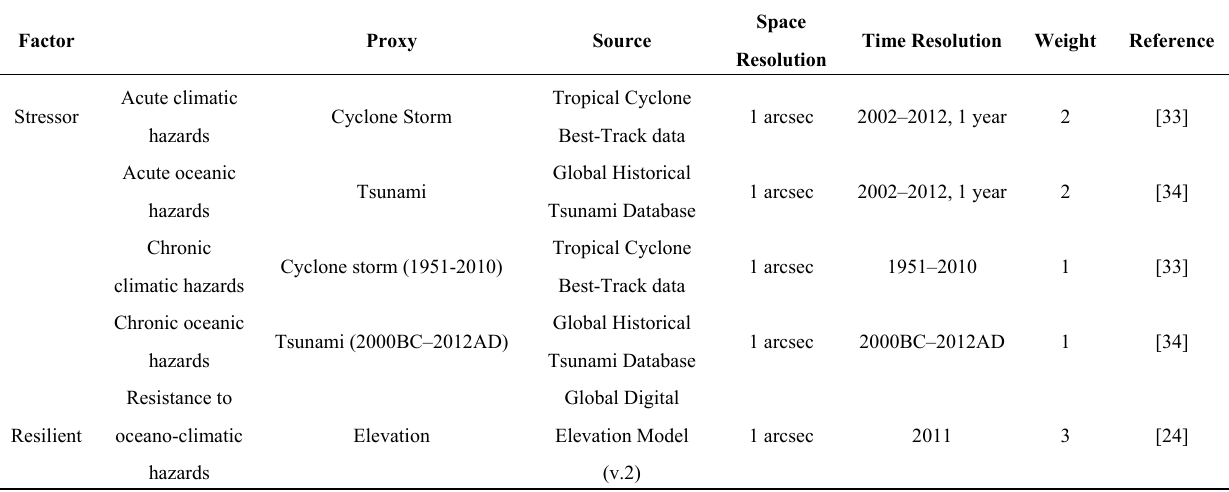
Table 1. Socio-economic stress and resilience exogenous factors, space-time data features, weighting and justification of the factors. The justification is rooted in the main references that link the factor with its relevance to the Japanese socio-economic resilience related to coral